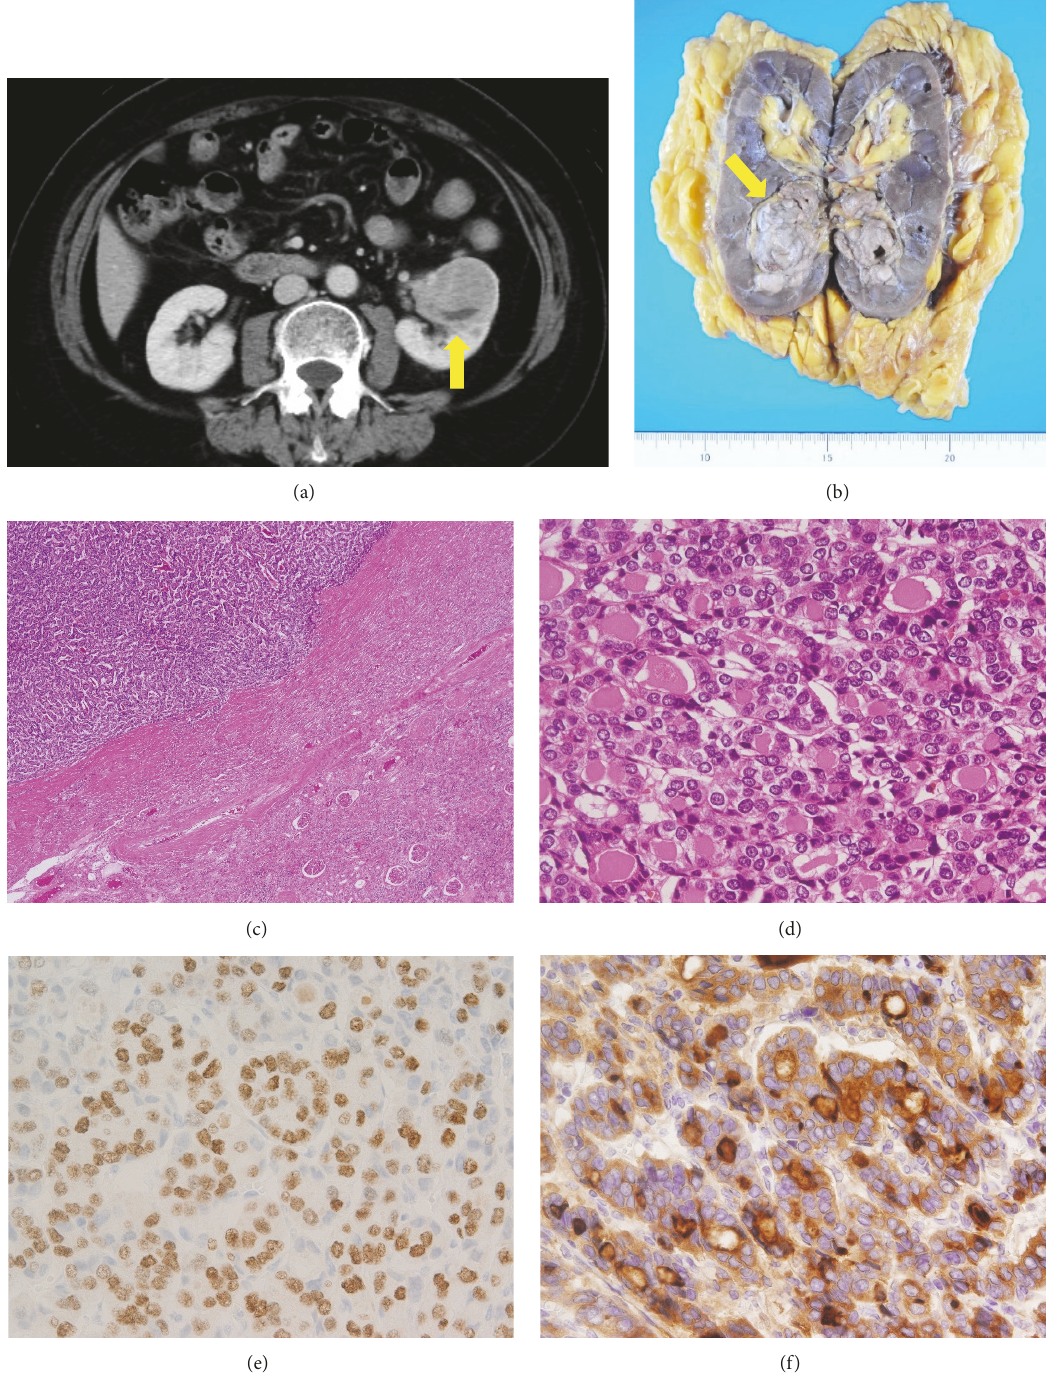
Figure 2: (a) Computed tomography showed the left kidney tumor (arrow). (b) The left nephrectomy specimen contained a light brown tumor measuring 4.5cm × 4.4cm on the lower pole arrow. (c, d) Histologic sections of the resection specimen showed that the tumor formed a follicular structure, and was infiltrating and proliferating. (c): Original magnification x200, (d): Original magnification x400. (e, f) Immunohistochemistry revealed positive for thyroid transcription factor 1 (e) and thyroglobulin (f). Original magnification